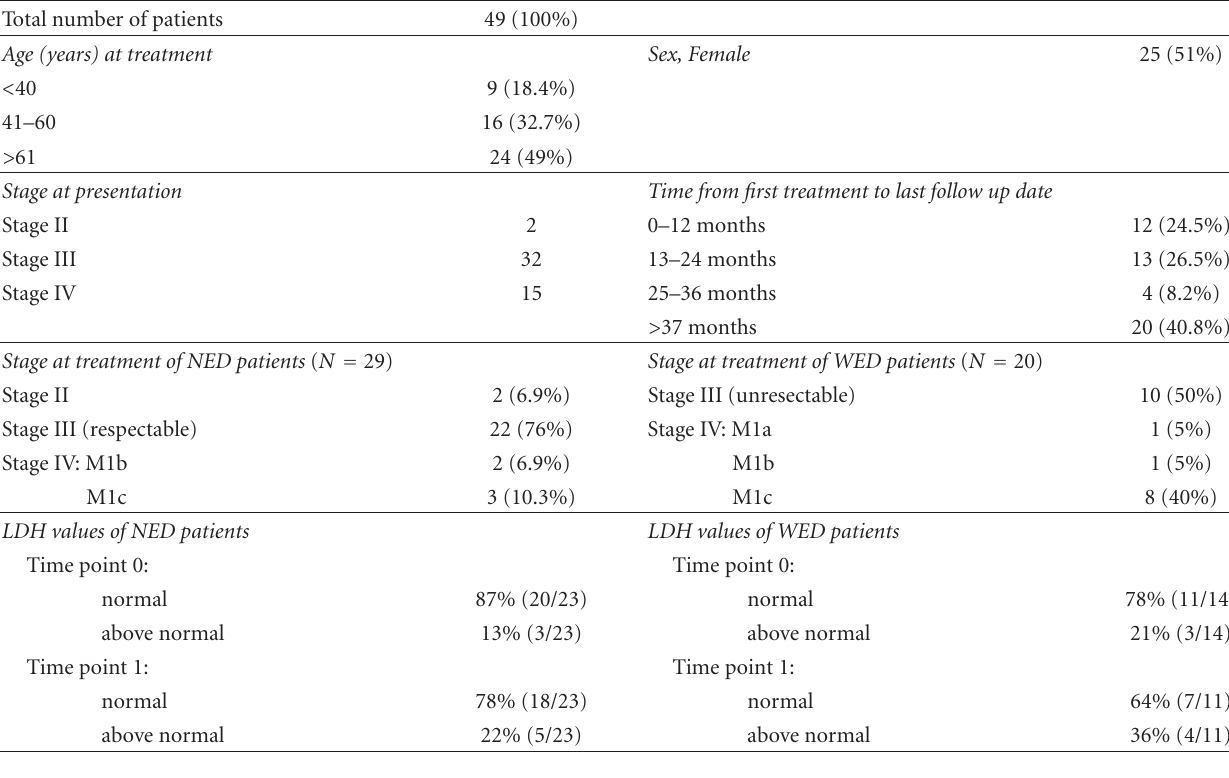
Table 1: Depiction of the clinical characteristics of 20 WED and 29 NED melanoma patients used in this study. Total number of patients